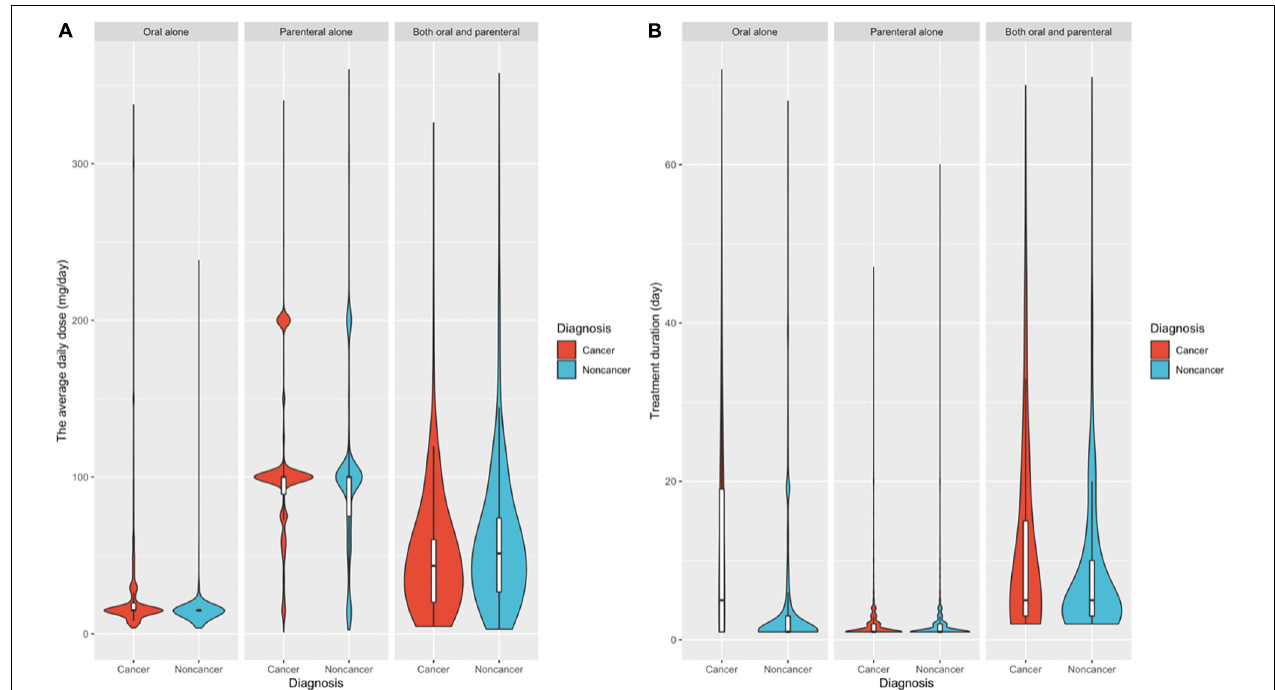
FIGURE 3 | Distribution frequency of the average daily dose (A) and treatment duration (B) in patients with cancer and noncancer diagnoses.